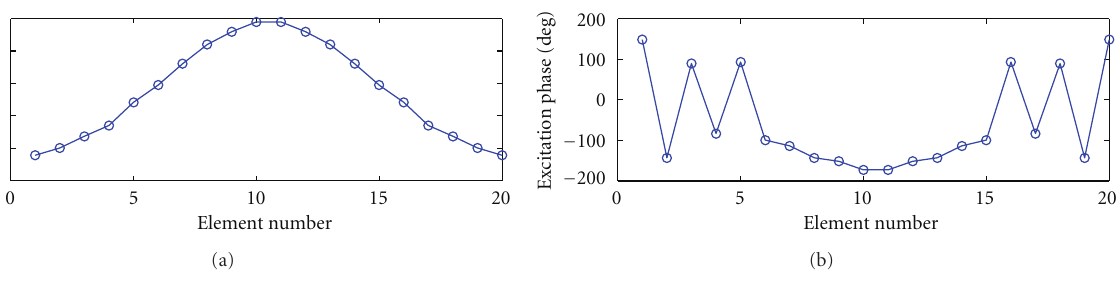
Figure 1: Amplitude and phase excitation (experiment I).